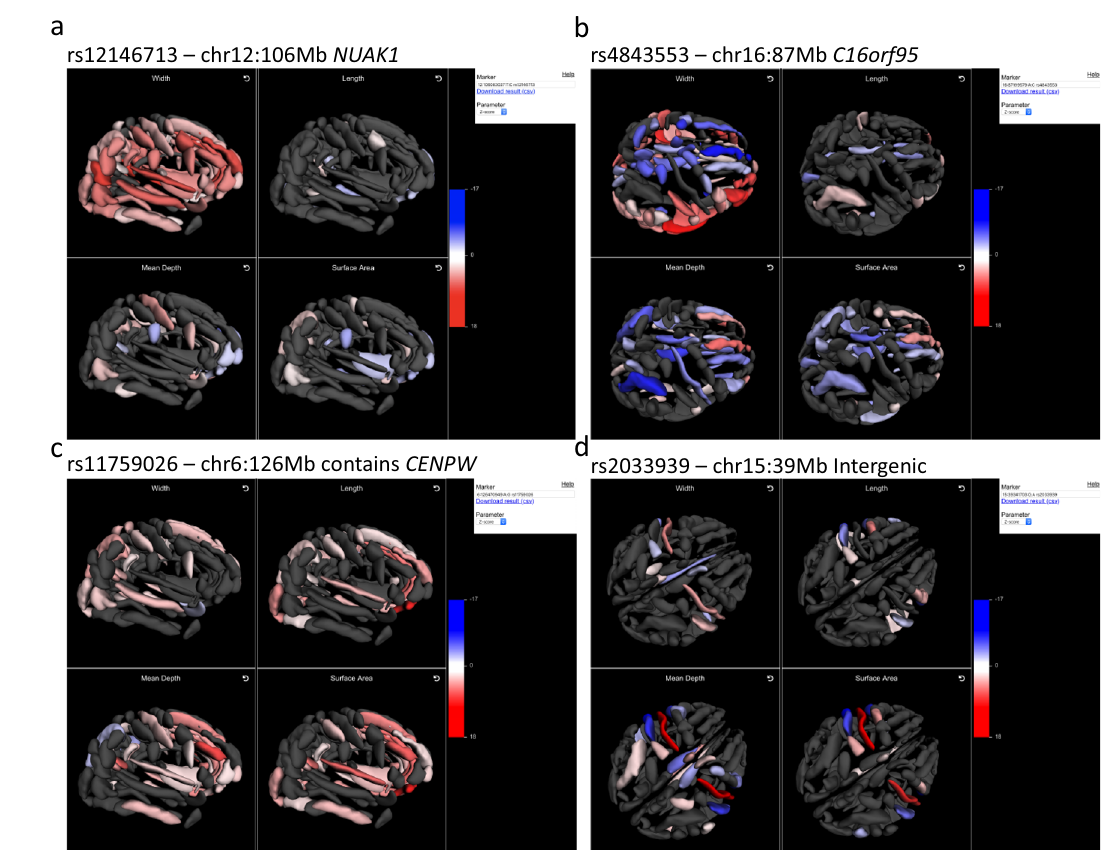
Fig. 5 | Three-dimensional visualisation of brain sulcal associations (Z-scores) for four exemplarpleiotropic loci. An interactive online tool,available at https:// enigma-brain.org/sulci-browser, was used to visualise genetic in fl uences on sulcal morphology in three dimensions, revealing ( a ) widespread, positive associations between rs12146713 ( NUAK1 ) and sulcal width measures, ( b ) widespread positive